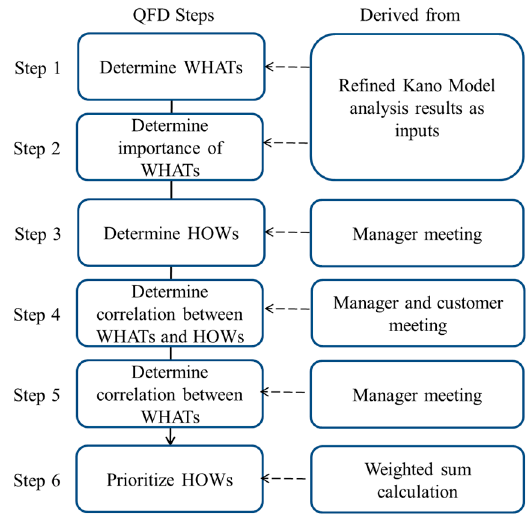
Figure 2. Quality function deployment (QFD) analysis process.